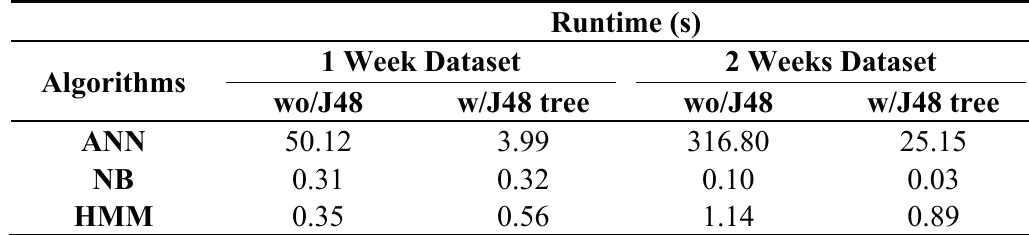
Table 8. Comparison of